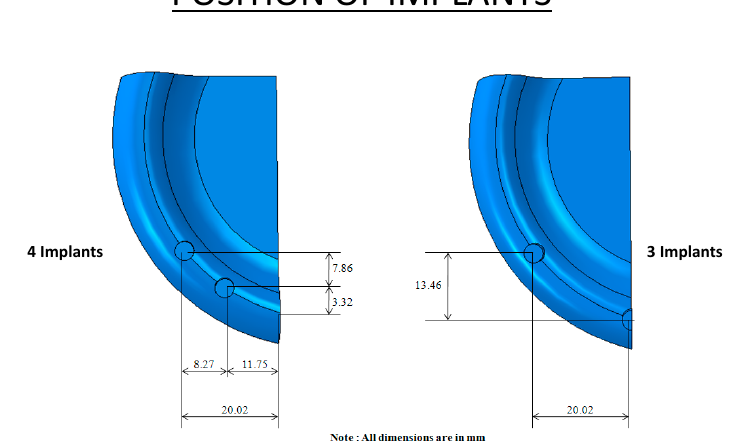
Figure 3. Position of implants for the four-implant and three-implant FEA models.